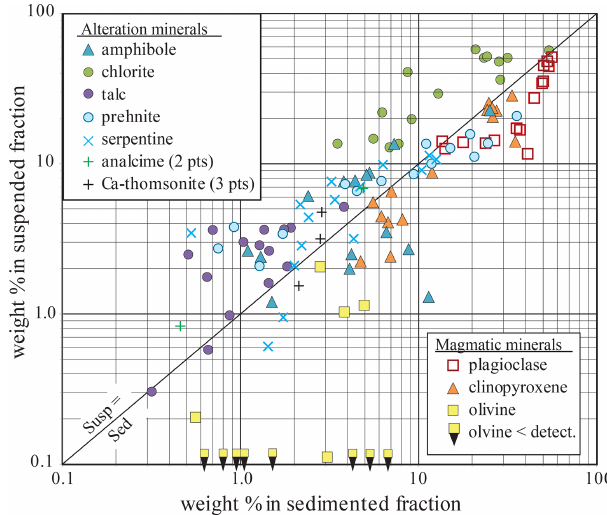
Figure 5. Graph comparing the weight percent (wt%) of the miner- als in the sedimented subsample with the weight percent of the clay- sized minerals in the suspended subsample in cores from Hole J as determined by X-ray diffraction and Rietveld refinement. The graph shows that magmatic minerals fractionated into the sedimented sub- sample whereas phyllosilicates fractionated into the suspended sub- sample.